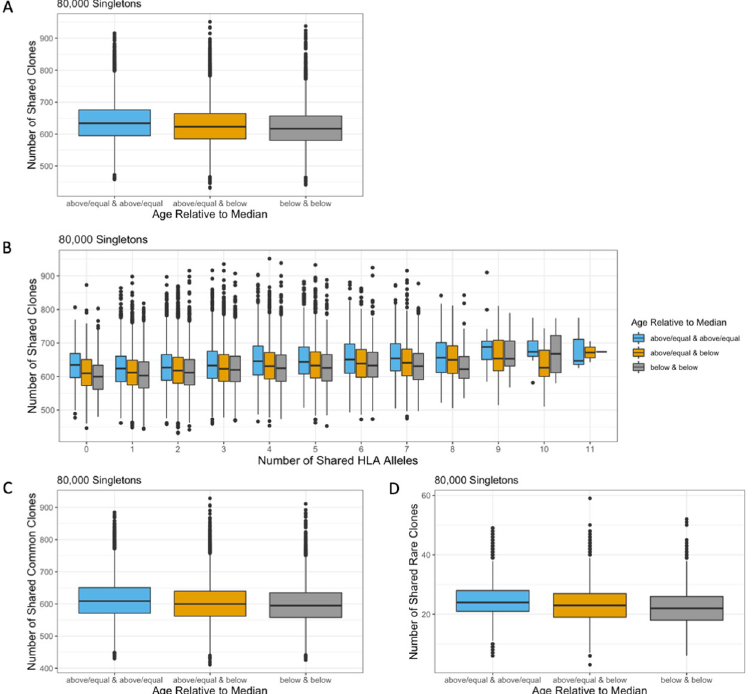
Fig 6. Impact of age on sharing of singleton TCR β clones. Individuals were stratified by the median age (42). (A) Older individuals shared more singletons than younger individuals. (B) Age impacted the sharing of singletons regardless of the number of HLA alleles. Older individuals shared more (C) common and (D) rare singletons than younger individuals.